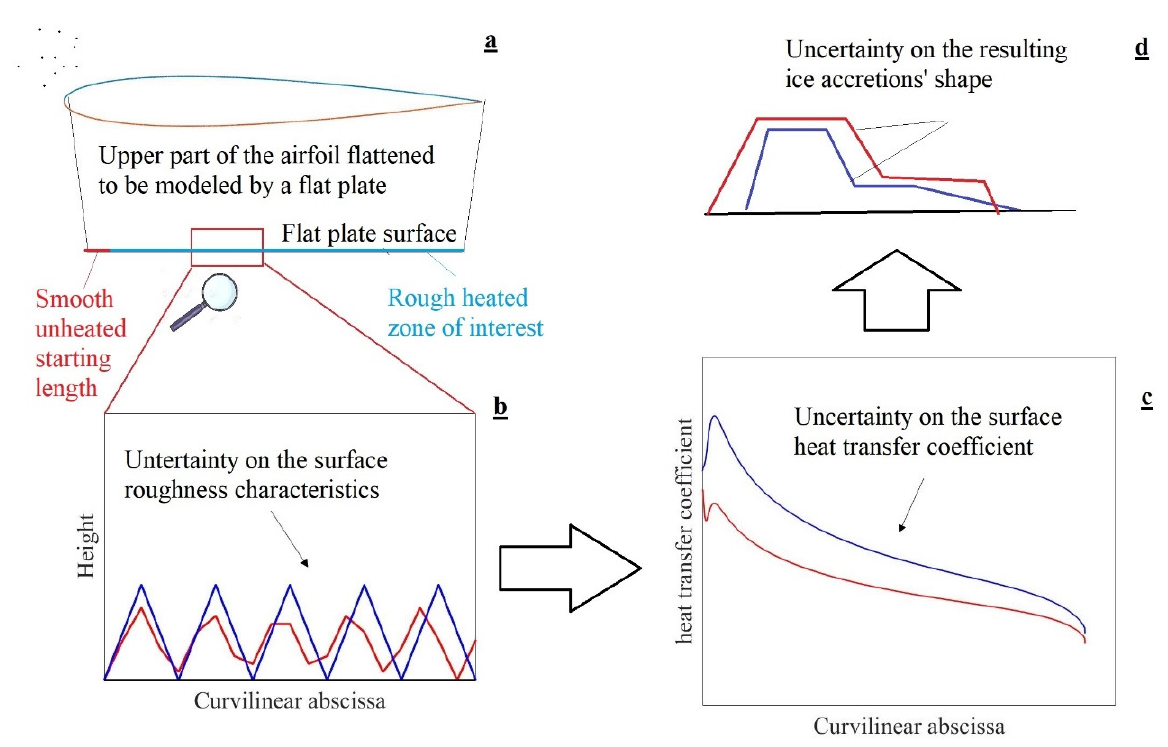
Figure 1. Uncertainty propagation from surface roughness to ice accretion shape.